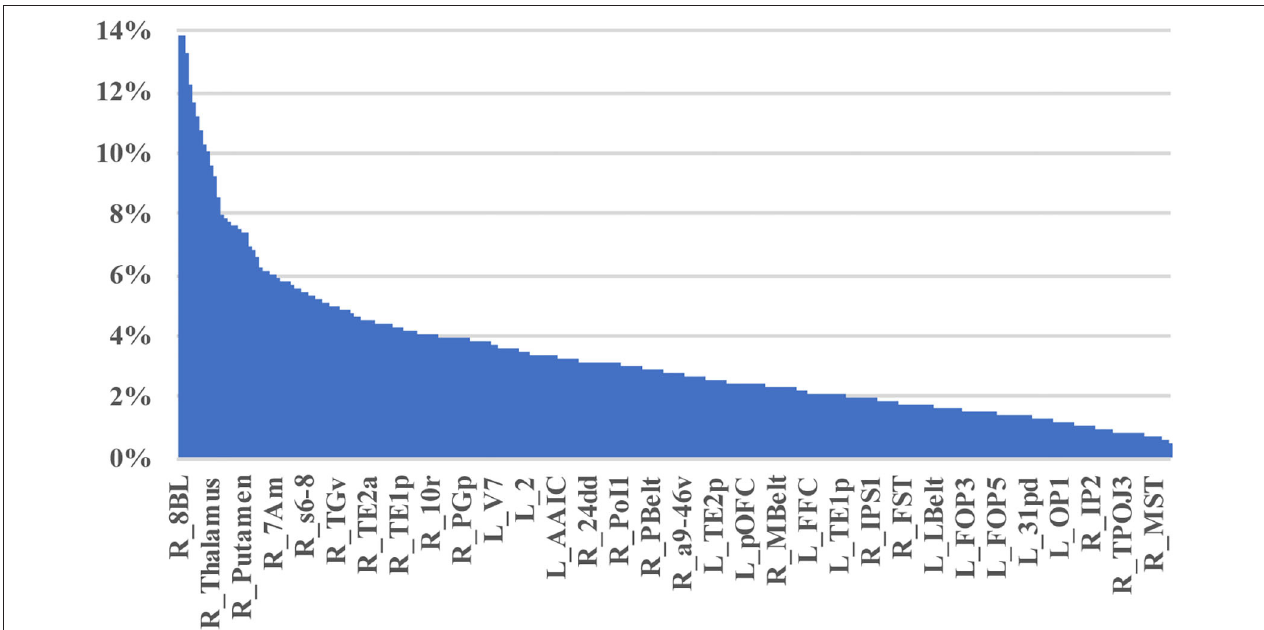
FIGURE 3 | A visual depiction of structural anomaly burden in these 21 subjects. This is a set of 377 bar graphs representing the total fractions of anomalies noted in each of the cortical parcellations and subcortical regions of interest expressed as a total % of possible anomalies. This gives a sense of which connections are most consistently abnormal compared to normal age-similar but healthy controls in non-variable areas. Note there are two inflection points in this graph that demonstrate steep transitions in the data. Areas to the left of the first inflection point are mostly subcortical structures, including the putamen, caudate, and thalamus, among others, and areas 10v, right 9M, bilateral 8BM, and right area 8BL. Areas between the two inflection points mainly include regions within the anterior cluster of the Default mode network. Most other areas have a lower anomaly burden and are to the right of the second inflection